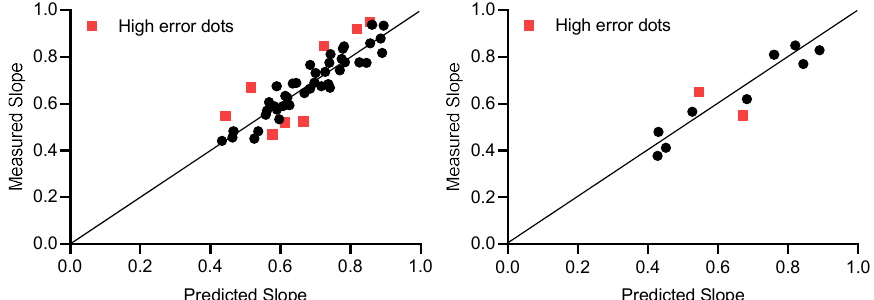
Figure 3. The slope obtained by the prediction and the slope measured in the experiment. Training set on the left, test set on the right.